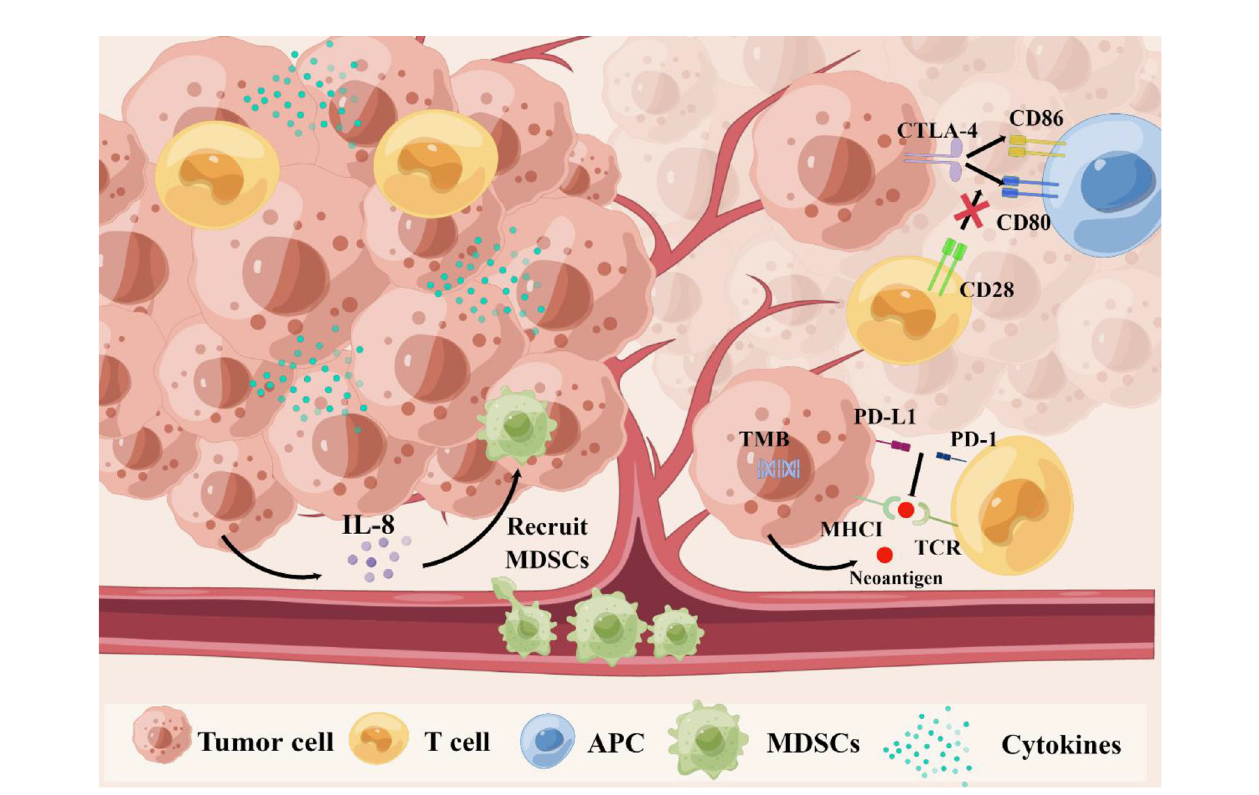
FIGURE 1 | The relationship between biomarkers and immune resistance. First, TMB might lead to new antigens and enhance immunogenicity. Second, the PD-1 combined with PD-L1 can transmit inhibitory signals and reduce immune activation, which leads to the immune escape of tumor cells. Third, CTLA-4 can compete with CD28 to bind to CD80 and CD86 on antigen-presenting cells (APC), and inhibit the activation signal. Fourthly, cytokines can regulate proliferation, differentiation and function of immune cells, tumor microenvironment, and even affect migration of cancer cells. Especially, tumor cells secrete IL-8 to recruit MDSCs into the tumor microenvironment to induce immunosuppression, and promote tumor progression. CTLA-4, cytotoxic T lymphocyte antigen-4; IL-8, interleukin-8; MDSCs, myeloid- derived suppressor cells PD-1, programmed cell death protein 1; PD-L1, programmed cell death ligand 1 TMB, tumor mutational